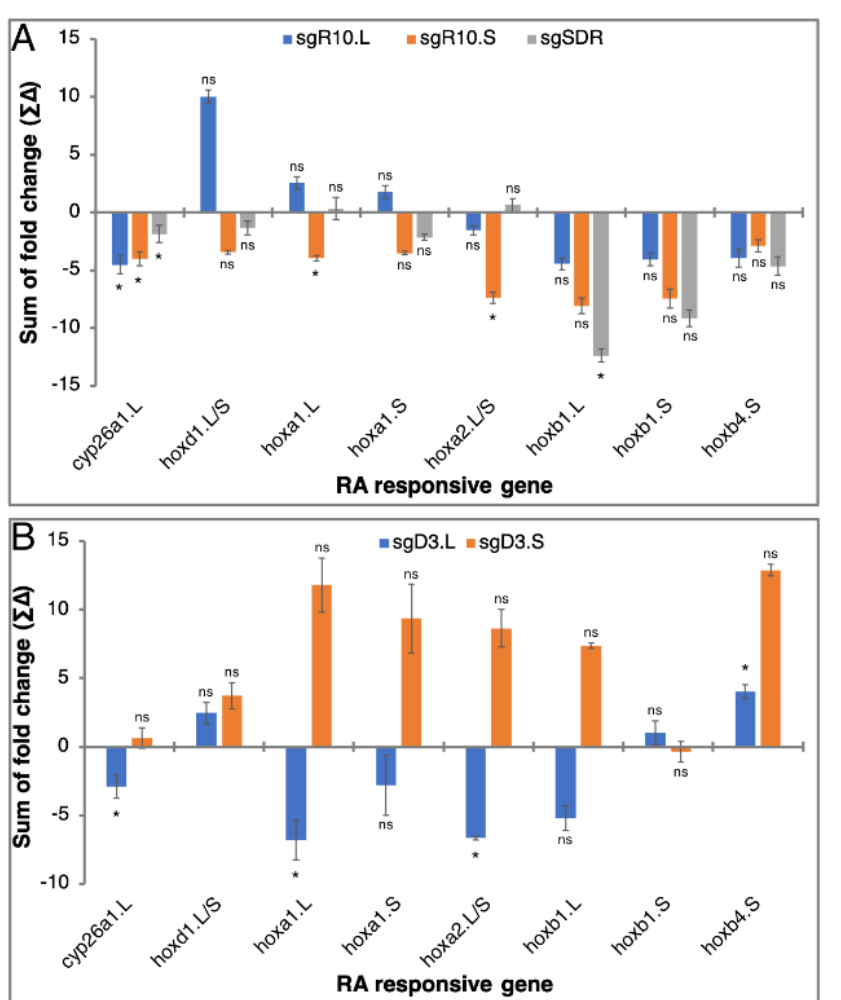
Figure 8. Regulation tightness score of the RA-responsive genes in CRISPant embryos. To calculate the regulation tightness score (∑∆), the sum of the expression fold change was calculated for the RA-responsive genes: cyp26a1 .L, hoxd1 .L/S, hoxa1 .L, hoxa1 .S, hoxa2 .L/S, hoxb4 .S, hoxb1 .L, and hoxb1 .S.